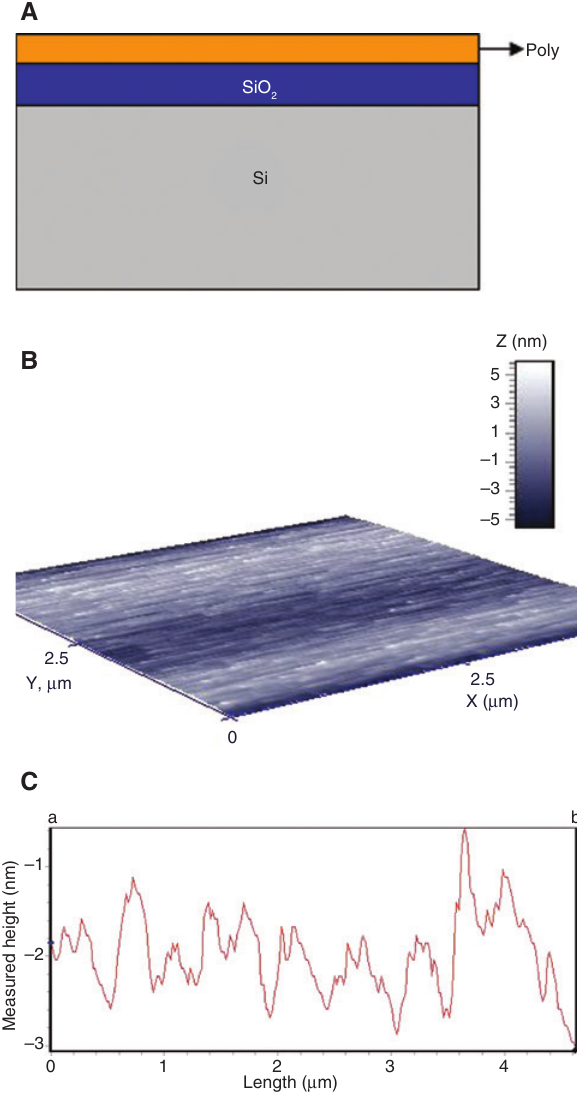
Figure 6: Silicon samples measured during validation of the model. (A) Cross section of the silicon sample layers (not to scale). (B) Sample topography. (C) Sample topography cross